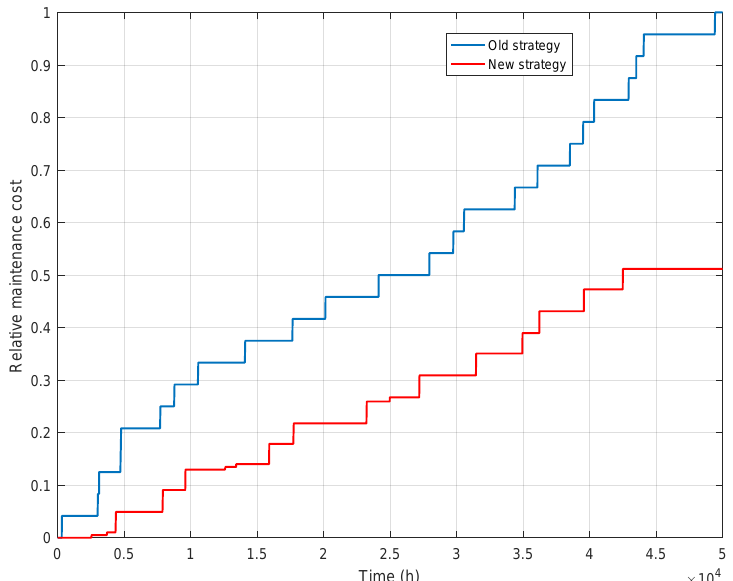
Figure 9. The plots show maintenance costs with the (“new strategy”) and without the (“old strategy”) remediation